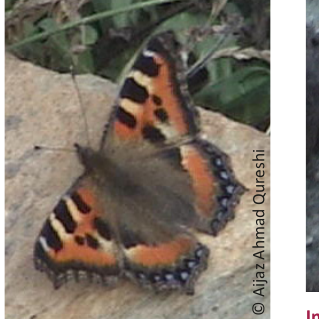
Image 2. Argynnis childreni Image 4. Lycaena phlaeas Image 3. Pupa of Argynnis childreni